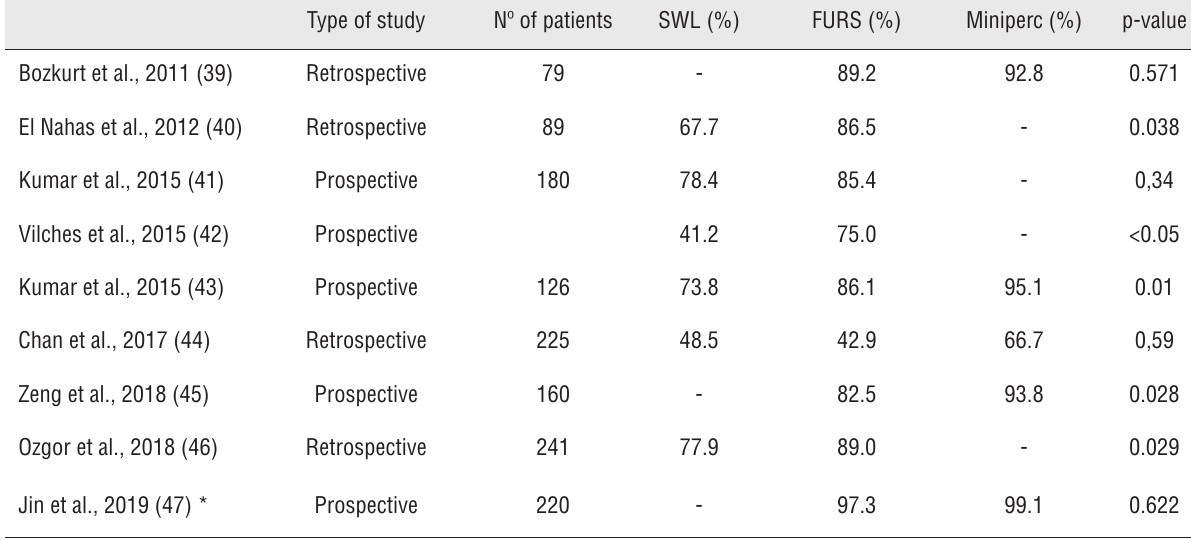
Table 2 - Stone-free rates for LPS 10-20 mm at two or three months after treatment. Type of study Nº of patients SWL